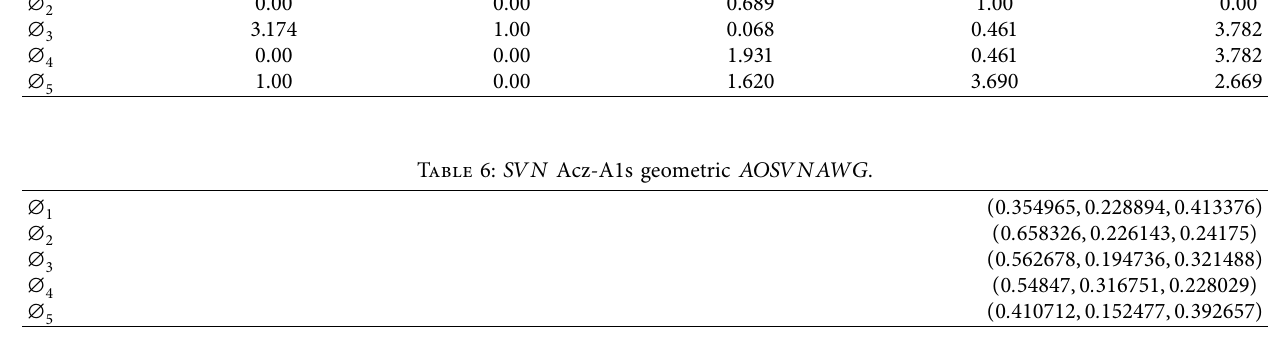
Table 5: +e valus of NDA